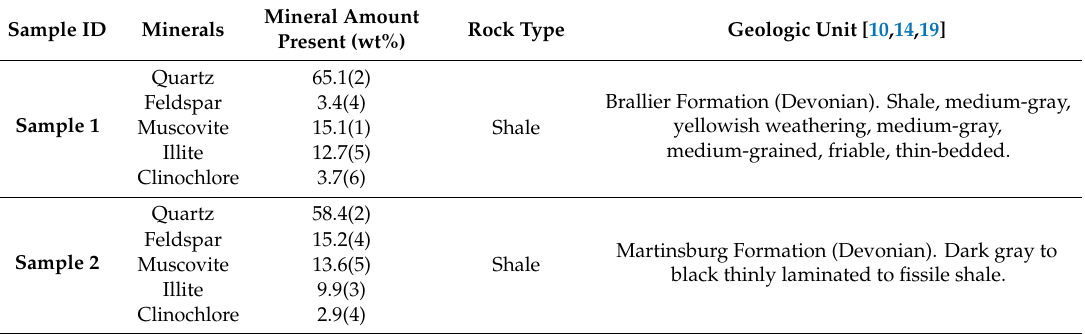
Figure 2. X-ray diffraction (XRD) patterns for ( a ) sample 1; ( b ) sample 2; ( c ) sample 3; ( d ) sample 4; ( e ) sample 5; ( f ) sample 6; ( g ) sample 7; ( h ) sample 8; ( i ) sample 9; ( j ) sample 10; ( k ) sample 11. Rietveld refinement results are reported in Table 1. Table 1. Mineralogy of the samples collected at the Edith J. Carrier Arboretum. Standard deviation in parentheses. The rock type was determined based on the quantitative mineralogic analyses. The geologic unit was determined using the hand specimen